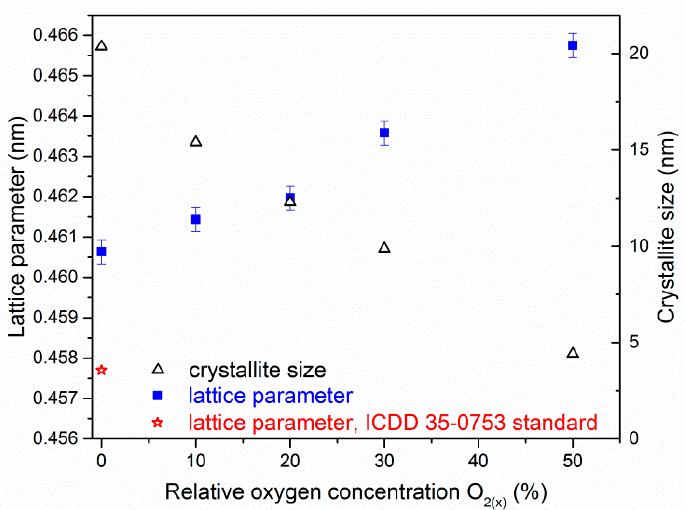
Figure 8. Lattice parameter and crystallite size of ZrON coatings dependent on O 2(x) .